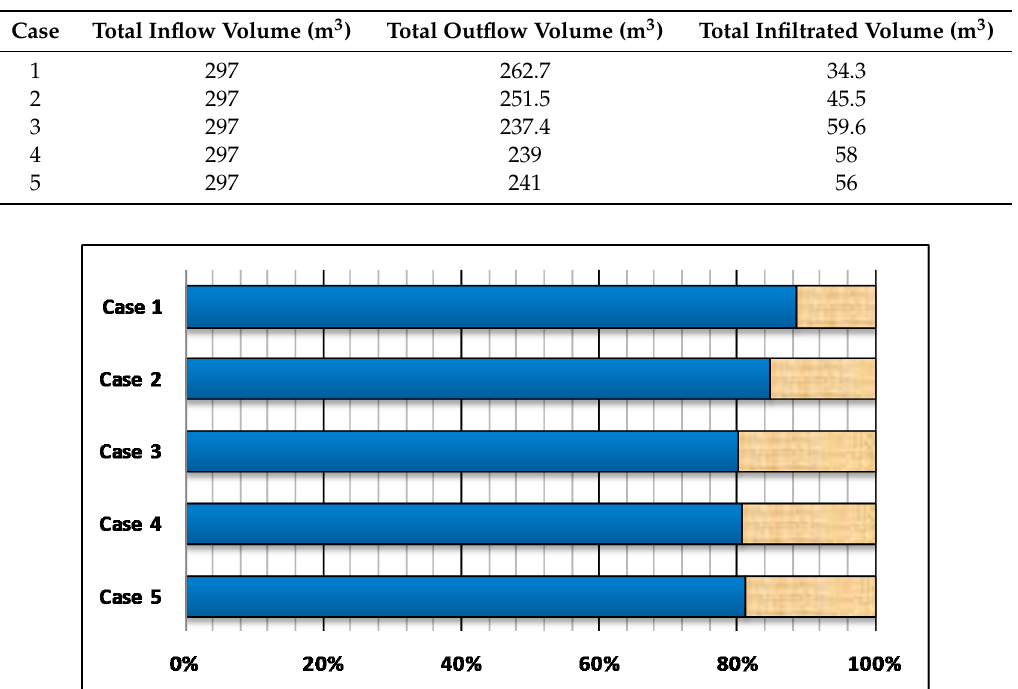
Figure 12. The percentage of the total volume of conveyed and infiltrated water. Table 4. The total inflow, outflow, and infiltration volumes after 90 min.